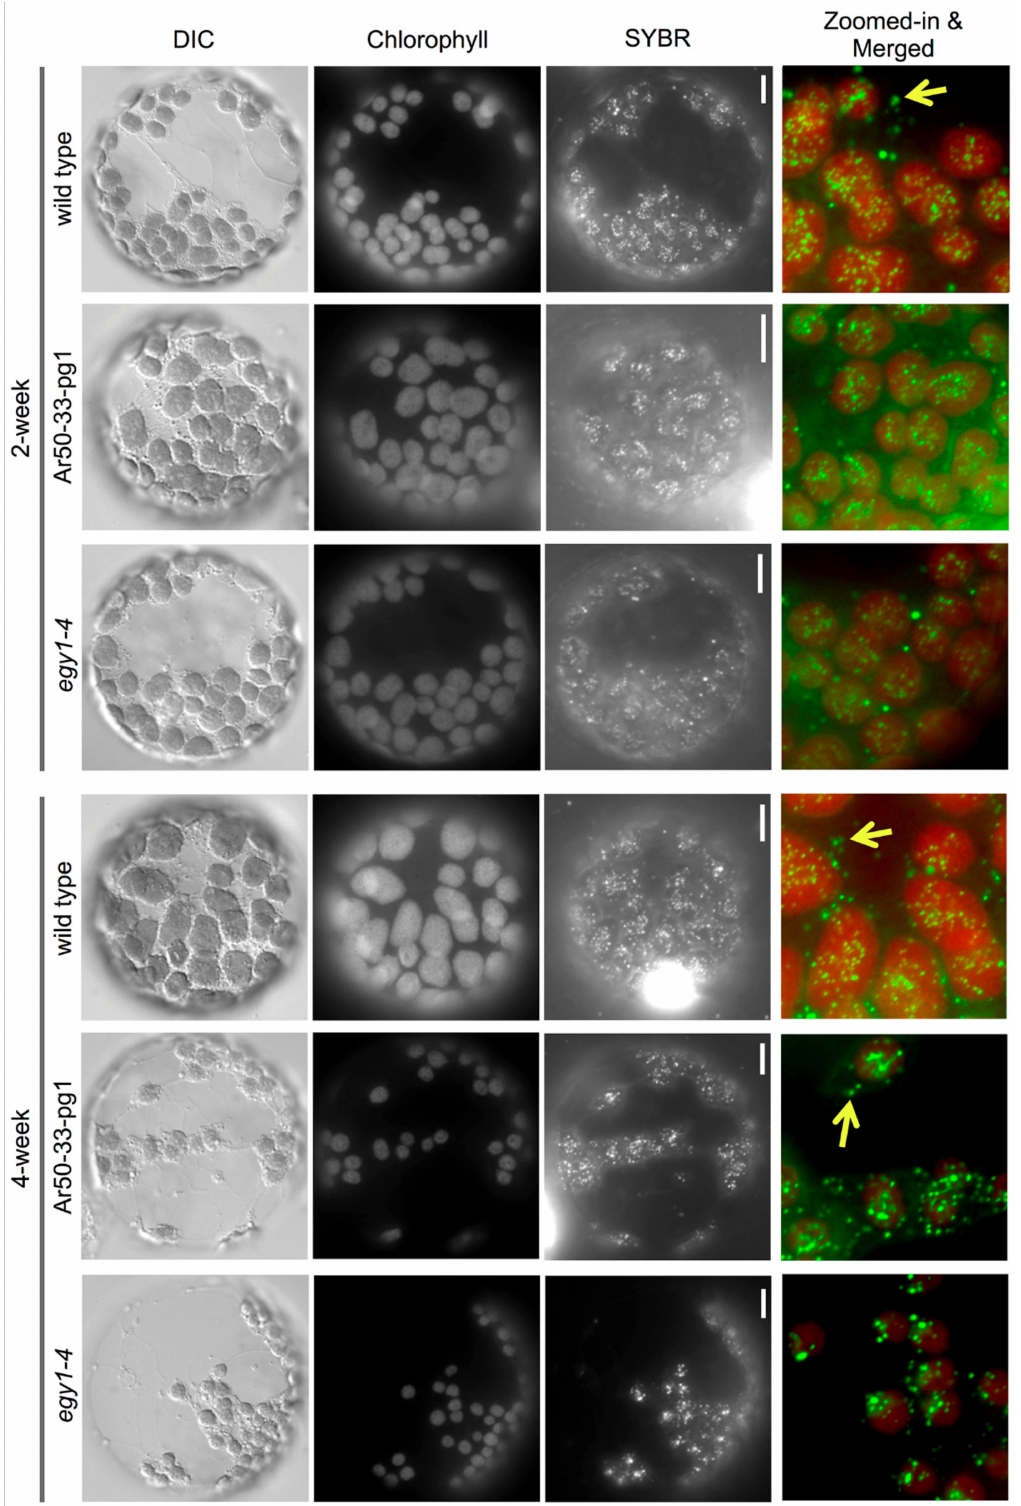
Figure 4. Fluorescence microscopy of leaf mesophyll protoplasts of wild type and mutant plants. Protoplasts from primary leaves of 2- and 4-week-old wild type, Ar50-33-pg1, and egy1-4 seedlings were stained with SYBR Green. Images of DIC, chlorophyll autofluorescence, and SYBR Green fluorescence, and merged images of chlorophyll and SYBR Green fluorescence (chlorophyll in red and SYBR Green in green) are shown. Arrows indicate mitochondrial nucleoids. See also Figures S5–S7. Bar = 10 µ